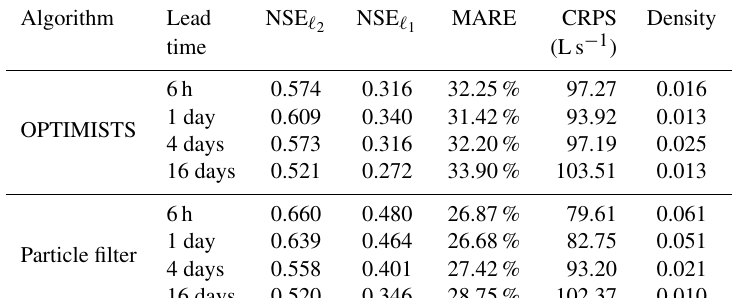
Table 6. Continuous hourly streamflow forecast performance metrics for the Indiantown Run application using OPTIMISTS ( (cid:49)t = 7 days, two objectives, n = 50, no optimization, and D-class kernels) and a traditional PF ( n = 50). The continuous forecast extends from September to December 2009. The NSE (cid:96) , NSE (cid:96) , and MARE (deterministic) are computed using the mean streamflow of the forecast ensembles and 2 1 contrasting it with the daily observations, while the CRPS and the density (probabilistic) are computed taking into account all the members of the forecasted ensemble.